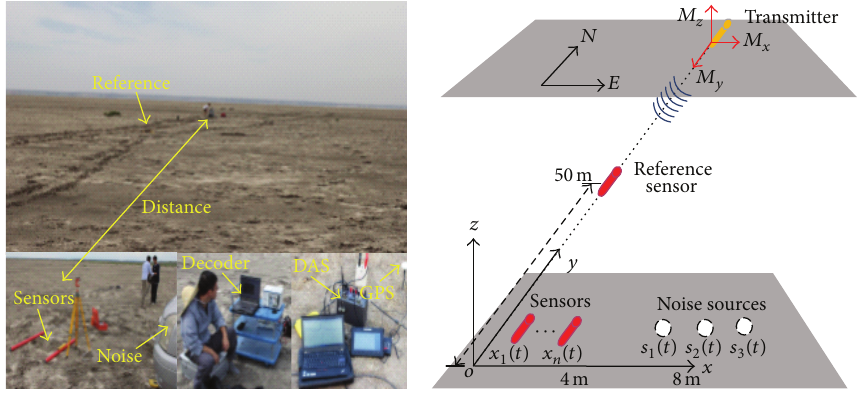
Figure 1: Field experiment.